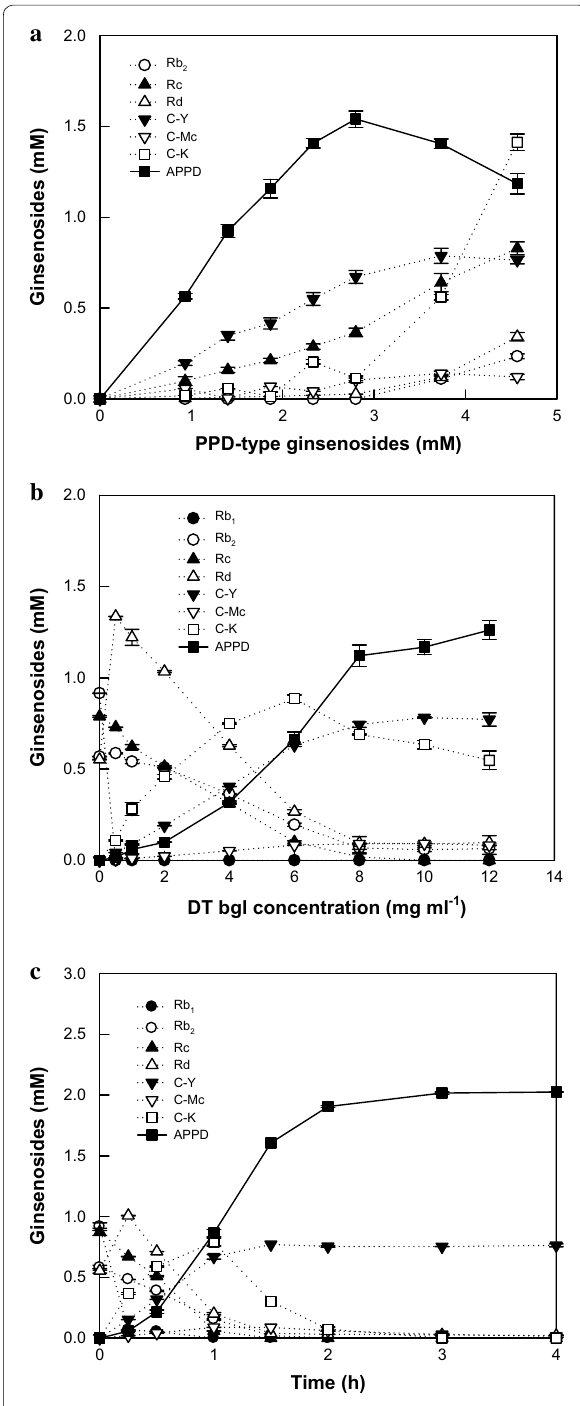
Fig. 1 Optimization of a the concentration of total protopanaxadiol (PPD)‑type ginsenosides in ginseng root extract as substrates; b the concentration of the β‑glycosidase from Dictyoglomus turgidum (DT‑ bgl) as an enzyme for 20( S )‑protopanaxadiol (APPD) production; and c the time‑course reactions for the production of APPD from PPD‑ type ginsenosides in ginseng root extract by DT‑bgl alone under the optimal conditions. Data represent the means of three experiments and error bars represent the standard